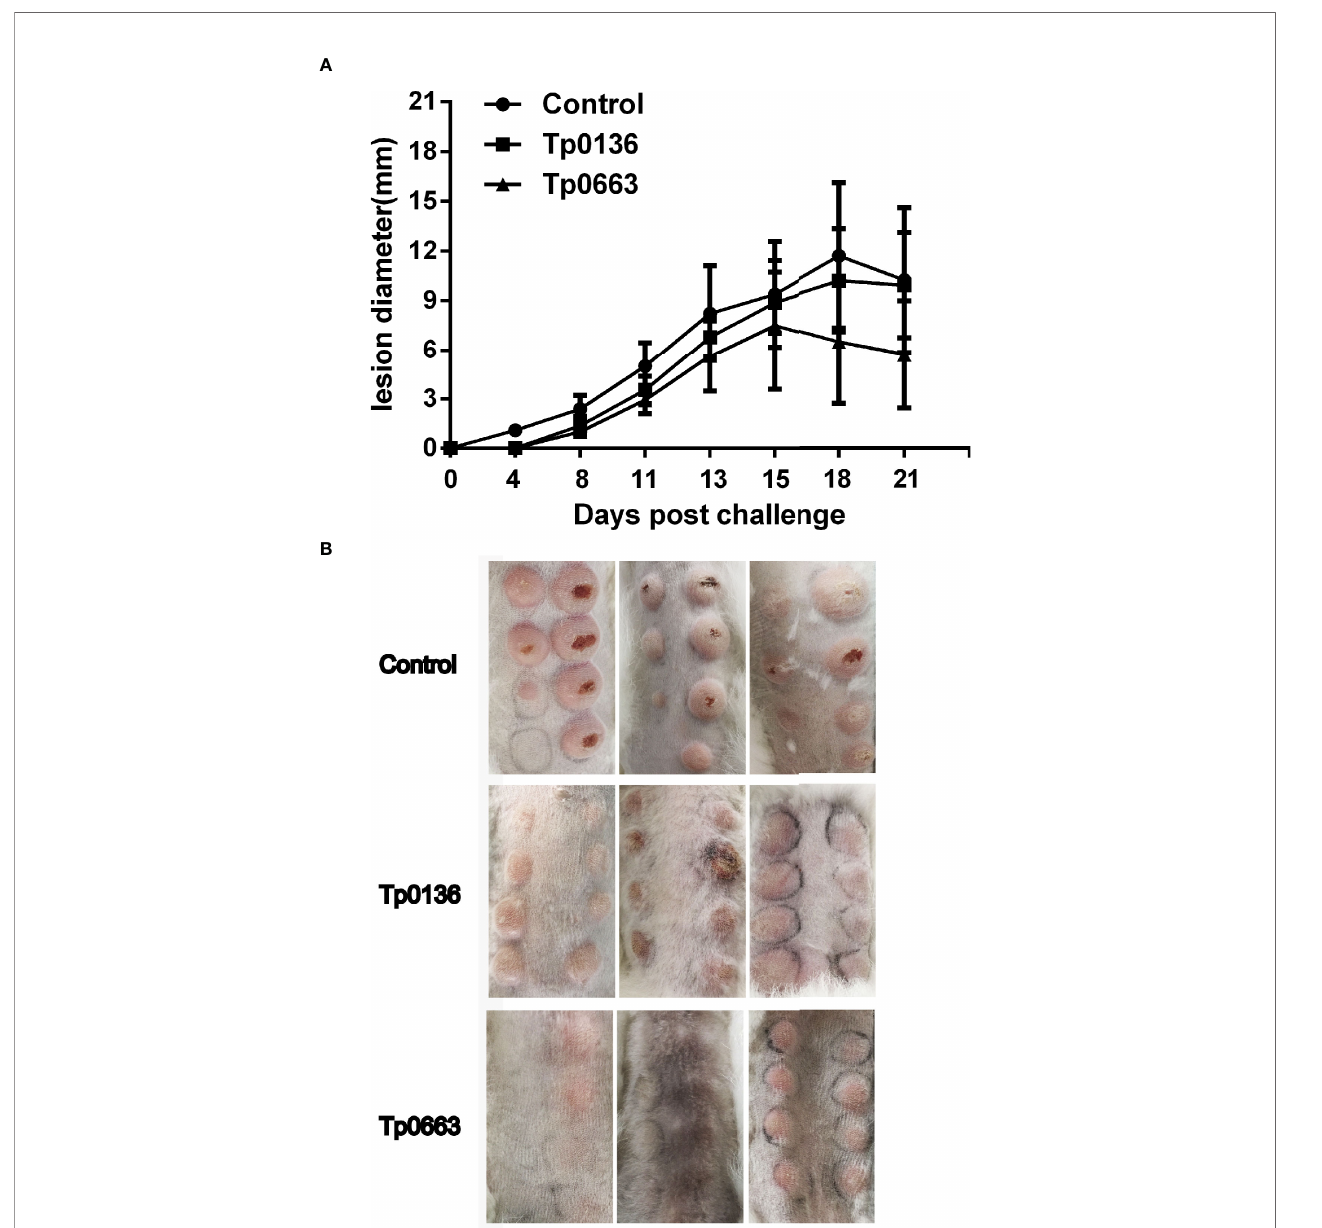
FIGURE 3 | Immunization with recombinant Tp0136 or Tp0663 protein attenuated lesion development. (A) Lesion diameters were monitored over 21 days in the control, Tp0136-immunized or Tp0663-immunized animals following T. pallidum challenge. (B) Indurated lesions from eight locations on the backs of the rabbits were taken 21 days post-intradermal challenge with T. pallidum (Nichols